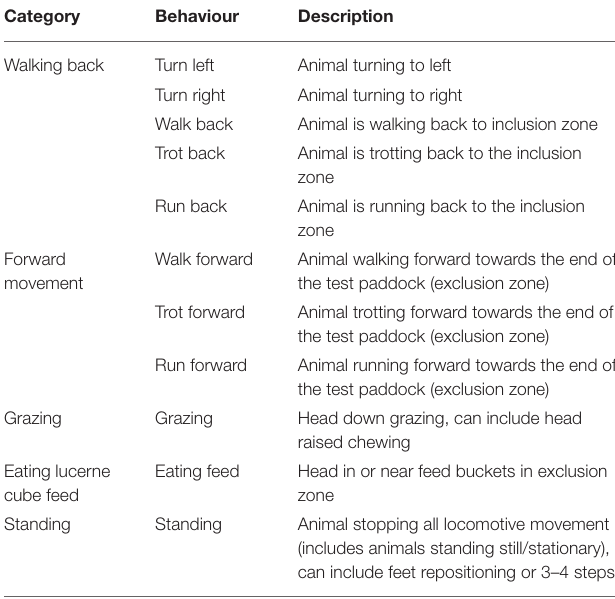
TABLE 2 | The ethogram used to describe the behavioural responses during the VF testing.